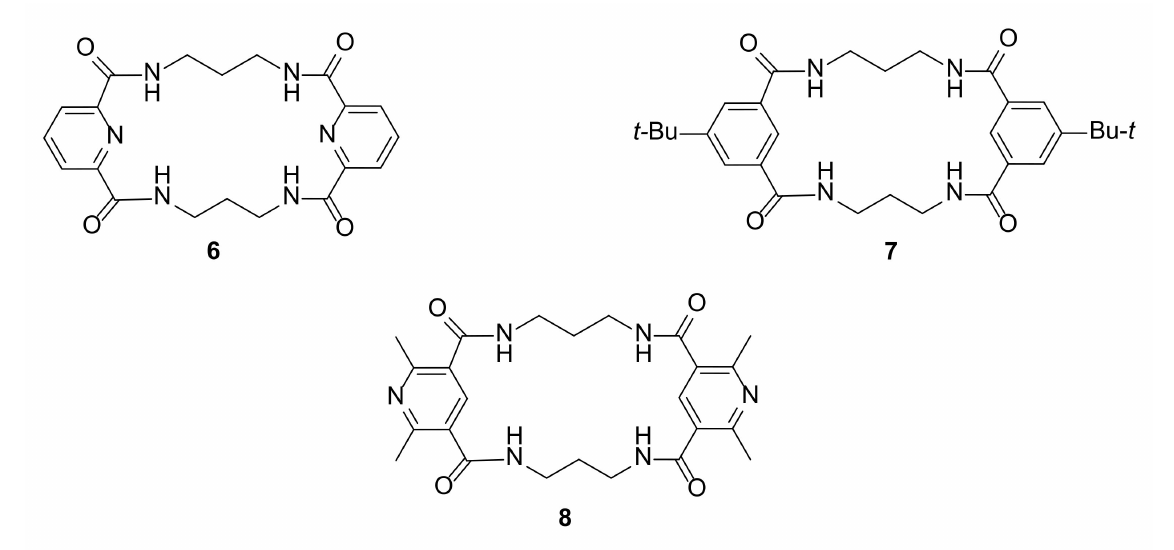
Figure 3. Macrocycles 6 – 8 with high affinity to chlorine binding.